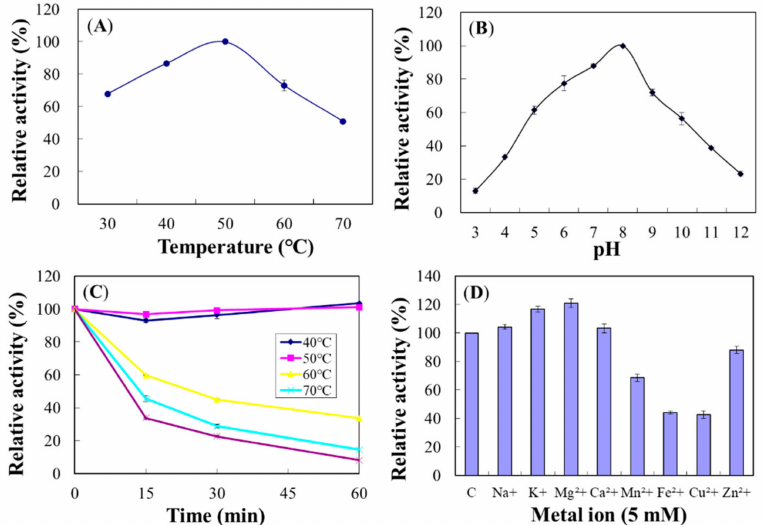
Figure 11. Effects of temperature ( A ), pH ( B ), thermostability ( C ), and metal ions ( D ) on the enzyme activity of Chi18A. The properties were characterized using the DNS method with colloidal chitin as a substrate.